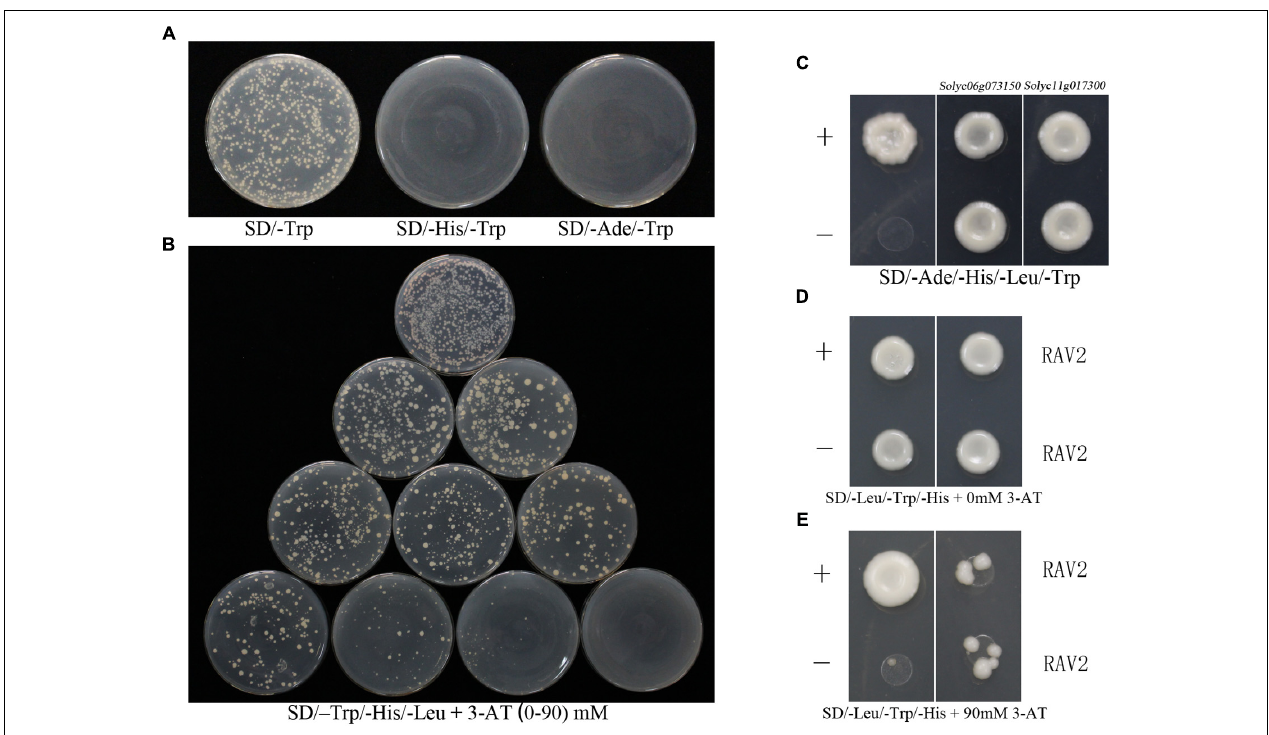
FIGURE 4 | CSN5B interacts with ATL78L whose promoter is bound by RAV2. (A) Self-activation assay of ATL78L. The yeast cells containing pGBKT7- ShATL78L transformants were tested on SD/-Trp, SD/-His/-Trp, and SD/-Ade/-Trp media. (B) Screen the concentration of 3-AT for the yeast one-hybrid system. The yeast cells containing pHIS2-ATL78LP were examined on the SD/–Trp/-His/-Leu media with the 0 to 90 mM 3-AT, respectively. (C) ATL78L interacts with two CSN5B proteins. The yeast cell transformants containing pGBKT7-53 + pGADT7-RecT (positive control), pGBKT7-Lam + pGADT7-RecT (negative control) and two pGBKT7- ShATL78L + pGADT7- CSN5B were tested on the SD/-Ade/-His/-Leu/-Trp media. (D,E) RAV2 binds to the promoter of ATL78L . Plasmids p53HIS2 + pGAD-Rec2-53 (positive control), pHIS2- ATL78LP + pGADT7 (negative control) and pHIS2-ATL78LP + pGADT7- SlRAV2 (the right column) were co-transferred into yeast strain Y187, the interactions were detected on SD/-Leu/-Trp/-His with 0 mM 3-AT (D) and 90 mM 3-AT (E)